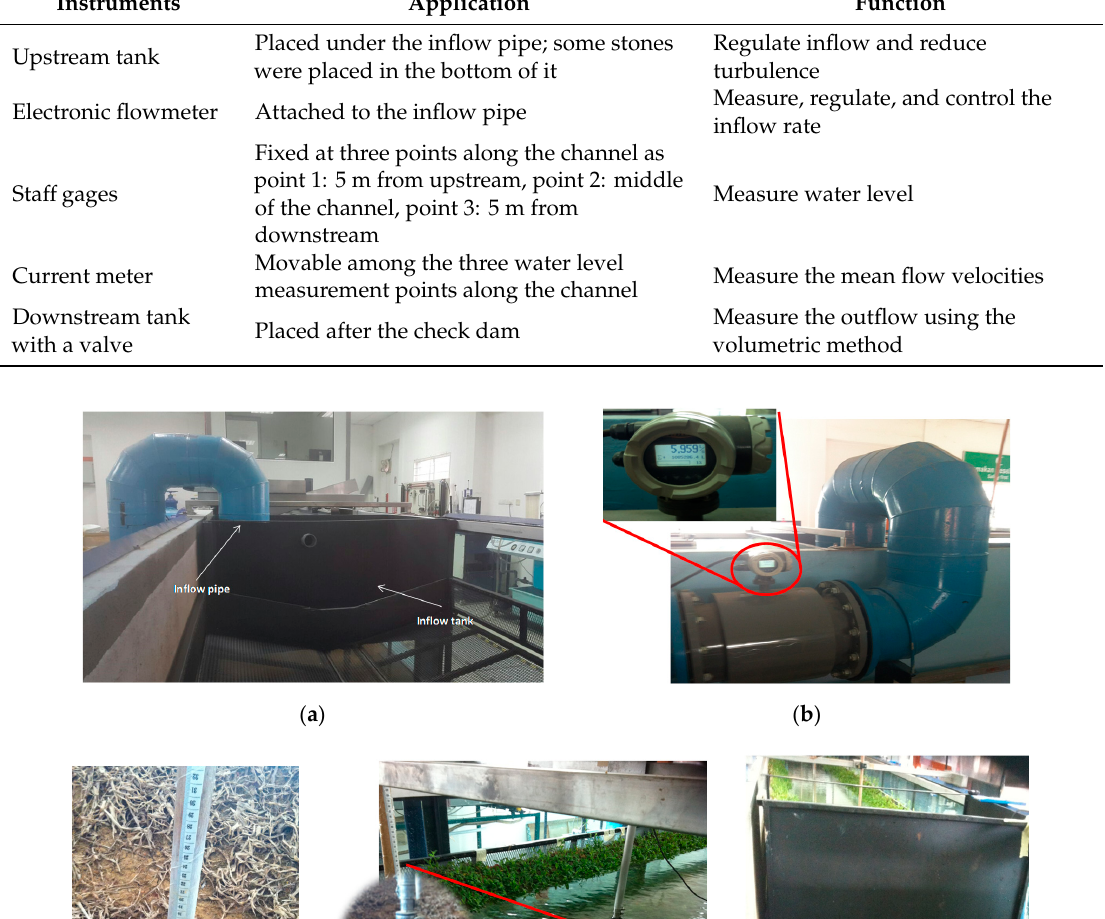
Table 1. The instruments used in the experiments for the measurement of water movements.